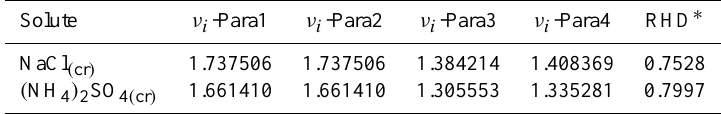
Table 2. ν i and RHD values at T o = 298 . 15 [ K ] and D s = 1 [ µm ] for the four models of Table 1. Solute